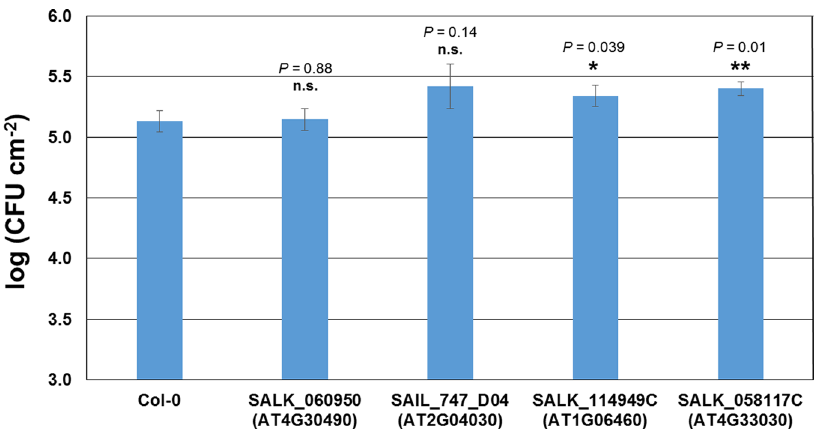
Figure 6. At2g04030 (CR88) and At1g06460 (ACD31.1) displayed increased susceptibility to DC3000 hrcC − . Growth of DC3000 hrcC − in plants were quantified three days post infiltration (OD 600 nm = 0.0002). Results presented are average ± stand error. n = 5, * p < 0.05, asterisks indicate the difference is significant compared to Col-0 by two-tailed Student’s t-